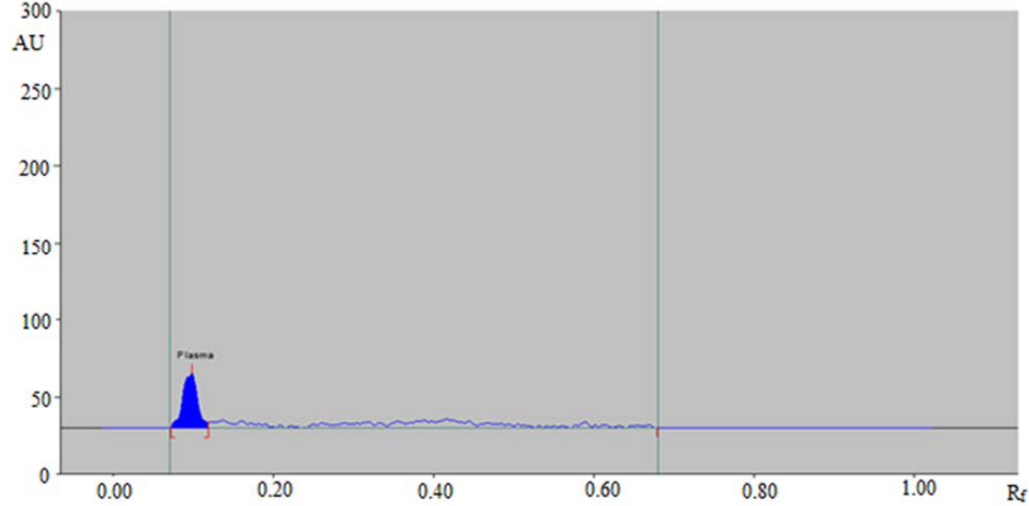
Figure 2. high ‐ performance thin ‐ layer chromatography (HPTLC) densitogram of blank human Figure 2. High-performance thin-layer chromatography (HPTLC) densitogram of blank human plasma sample. plasma sample.